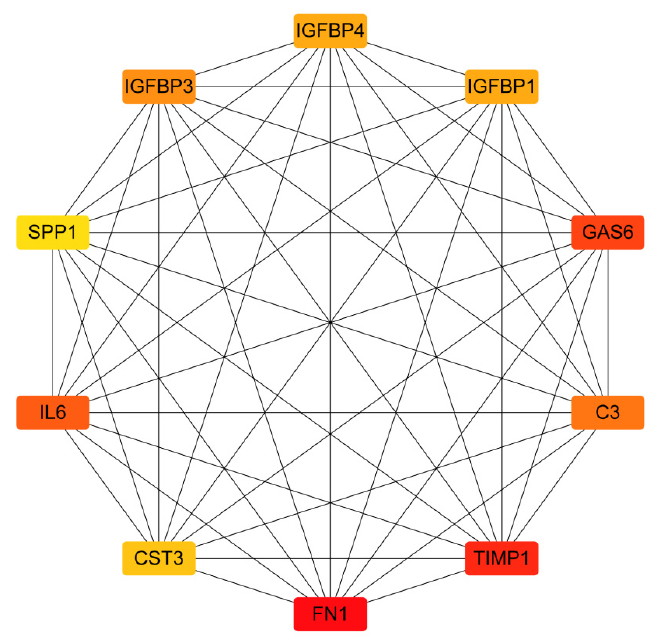
Figure 3. Hub gene analysis of the PPI network. The color change from yellow to red indicates the increasing importance of related genes in the network. The red color indicates the highest significance.